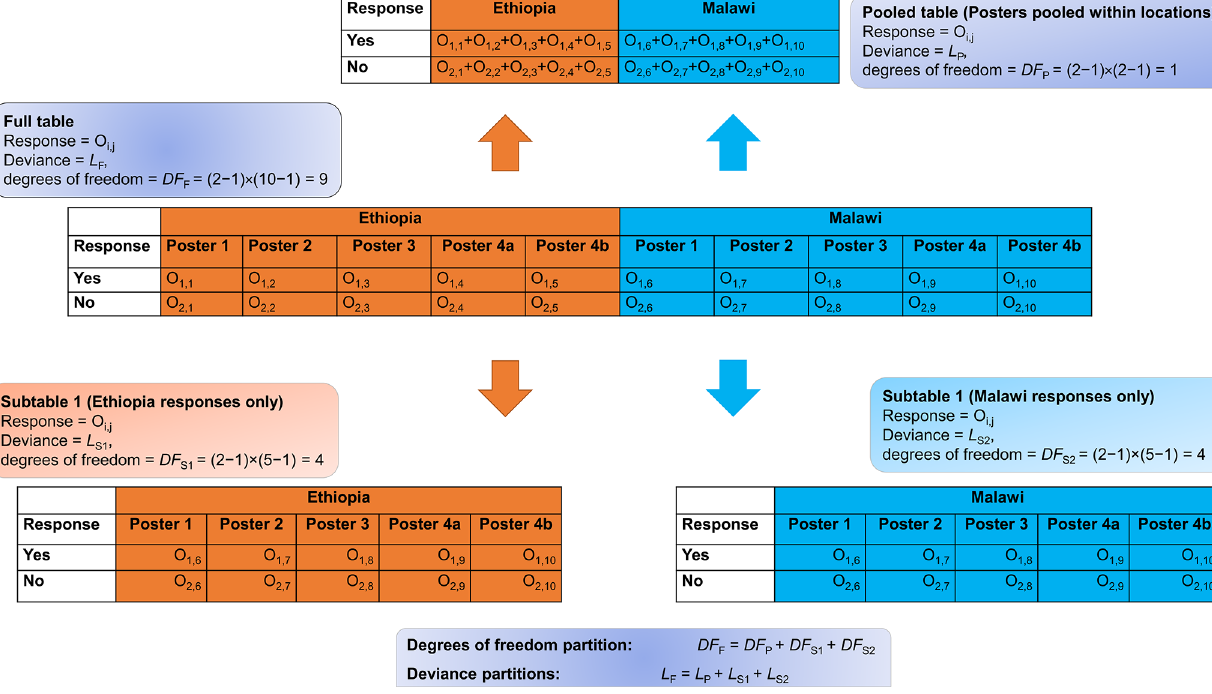
Figure A1. An illustration of how the log likelihood ratio can be partitioned into subtables and pooled tables. Table A1. The full contingency table showing how many individuals selected a given response to Q1 (interpretive task). The table is presented according to the location of the meeting and the method of communication. The figures in parentheses are the expected numbers, and e i,j is the product of the row and column totals ( n i and n j ) divided by the total number of responses ( N ).